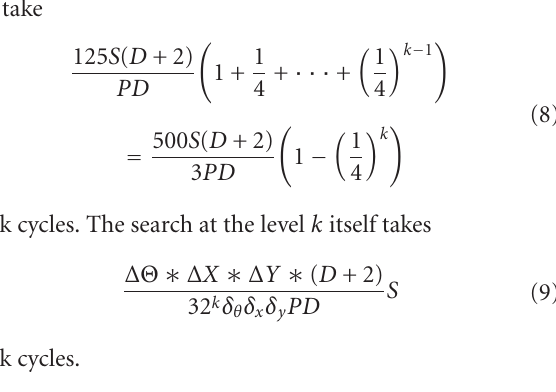
Figure 8: Store the original and decomposed images in the same memory bank in the DWT-based image